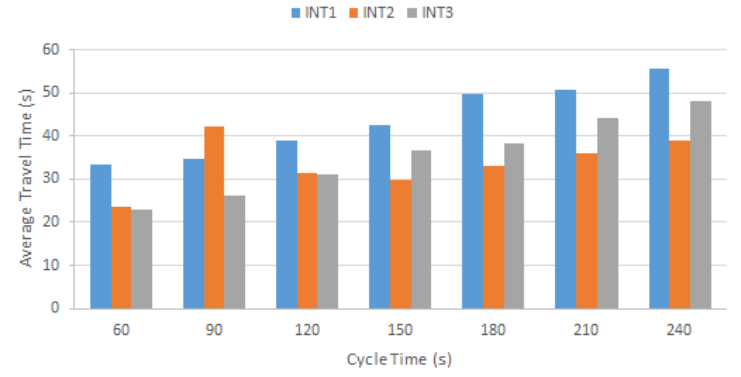
Figure 13. Vehicle average travel time after signal